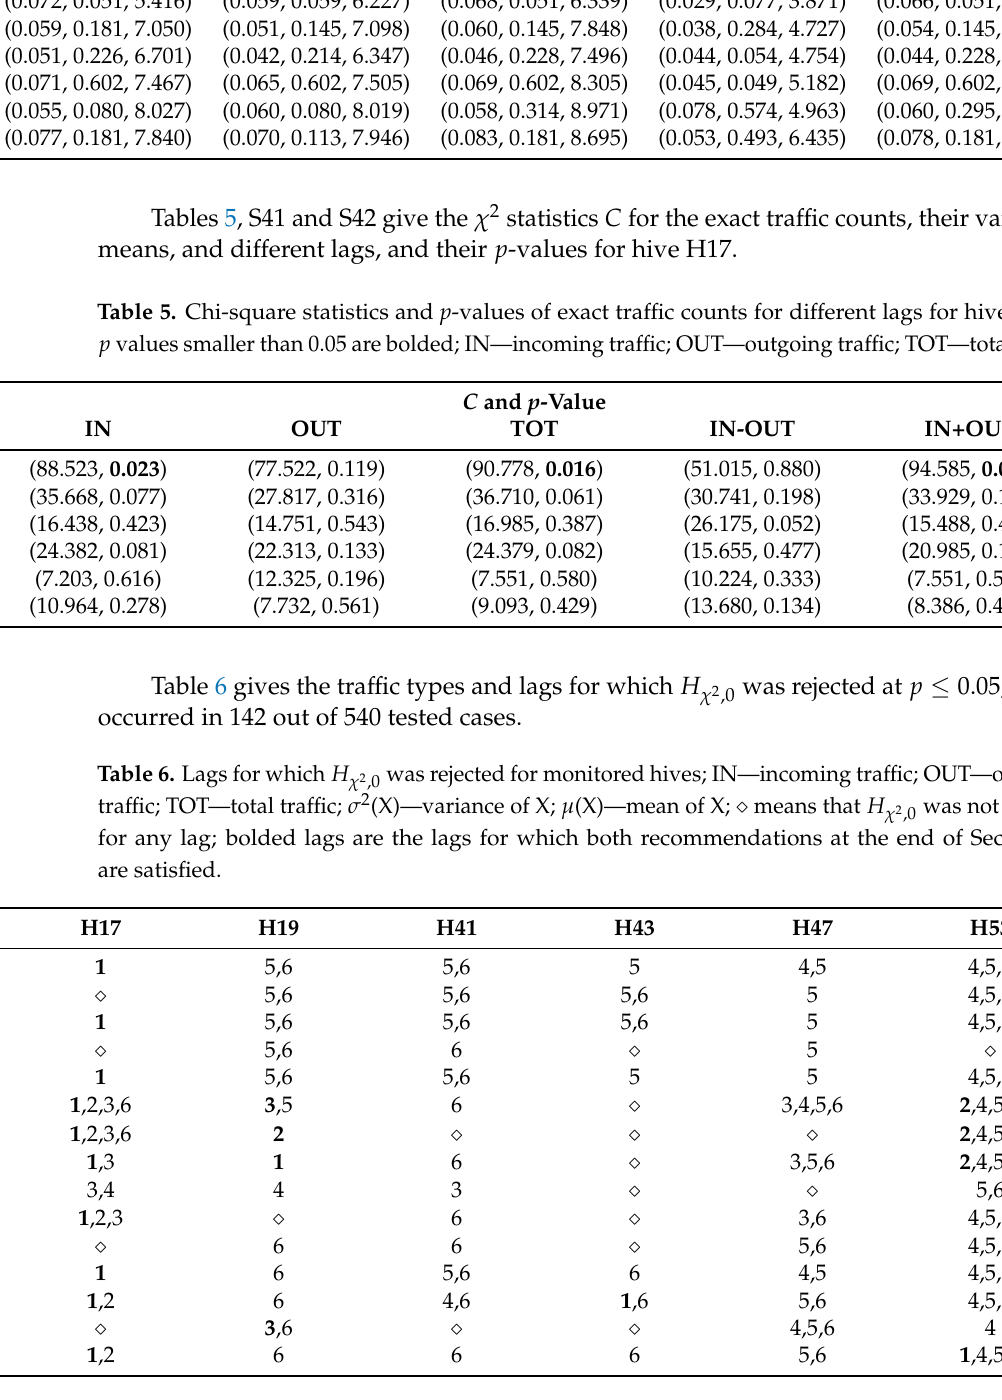
Table 4. The maxima and argmaxima of the absolute difference between the joint probability and the product of marginal probabilities of exact traffic counts and different lags for hive H17; each entry has format ( maxD , (cid:101) W , (cid:101) T ); IN—incoming traffic, OUT—outgoing traffic; TOT—total traffic; IN-OUT—difference between IN and OUT; IN+OUT—sum of IN+OUT; IN, OUT, TOT, IN-OUT, and IN+OUT are integers.